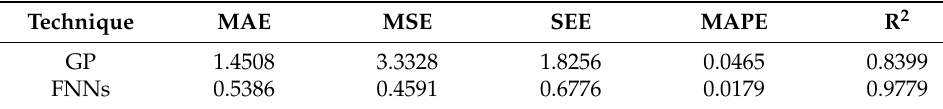
Table 6. Models efficiency metrics for Test 2.